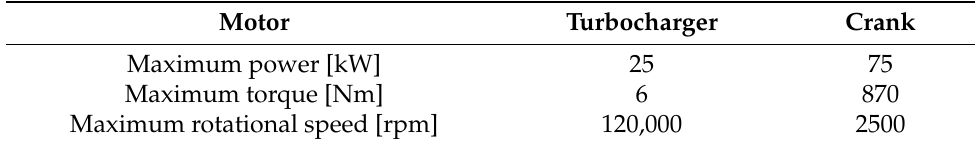
Table 2. Electric motor model’s